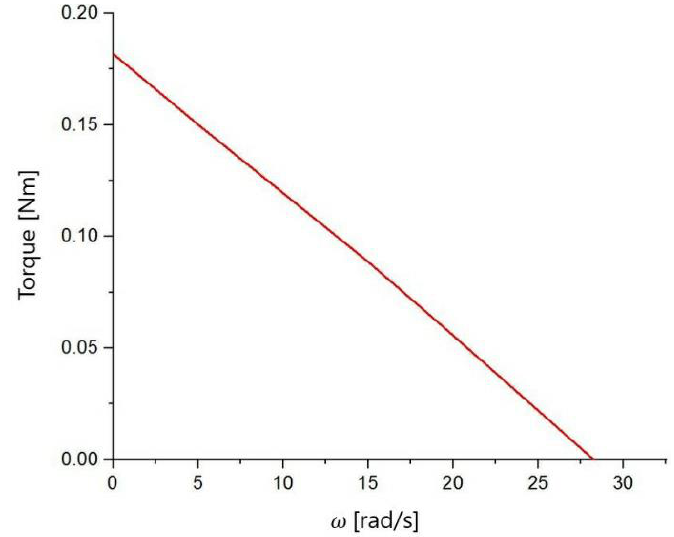
Figure 11. T–ω curve.